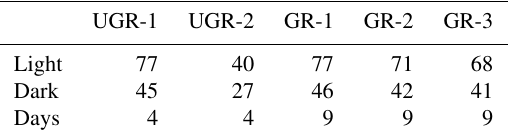
Table 1. Number of light (NEE) and dark ( R eco ) measurements for each chamber site and total number of measurement days that passed the quality screening. The lower data coverage of UGR-2 reflects the distribution of raw data collected and is not related to data quality